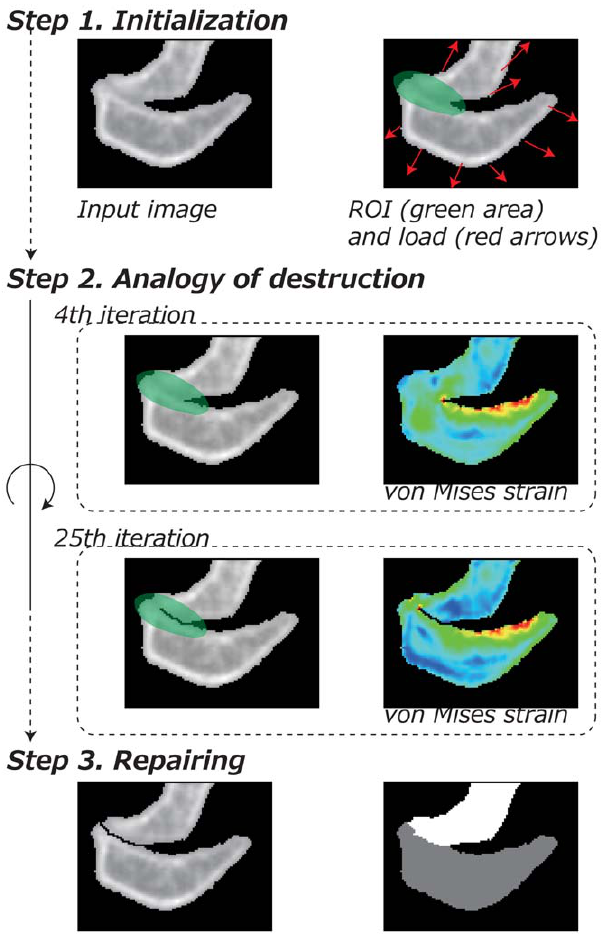
Figure 1. Flow chart of the proposed segmentation algorithm. Green area in the top and left middle are ROI and the red arrows show some representatives of loading forces. Images in the right and middle show distribution of von Mises strain and red pixels indicate high value. Using analogy of destruction we repeat removing these red pixels until the object gets separated along the interference region. In the bottom, the result of segmentation is shown where the removed pixels are salvaged to be included in the